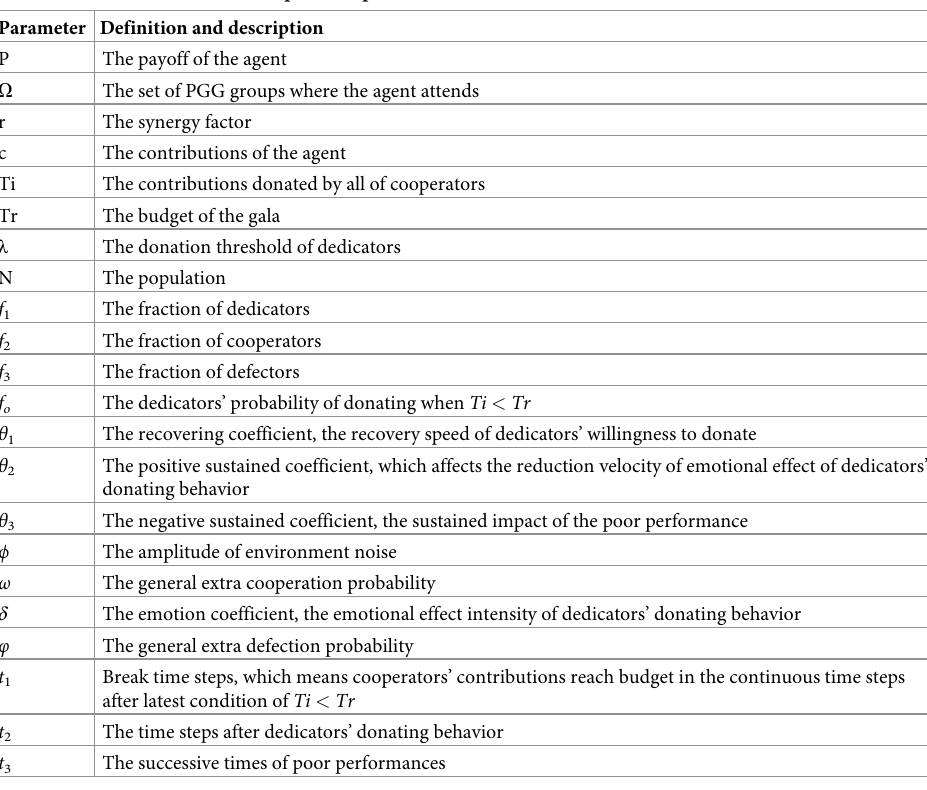
Table 1. The definitions and descriptions of parameters.